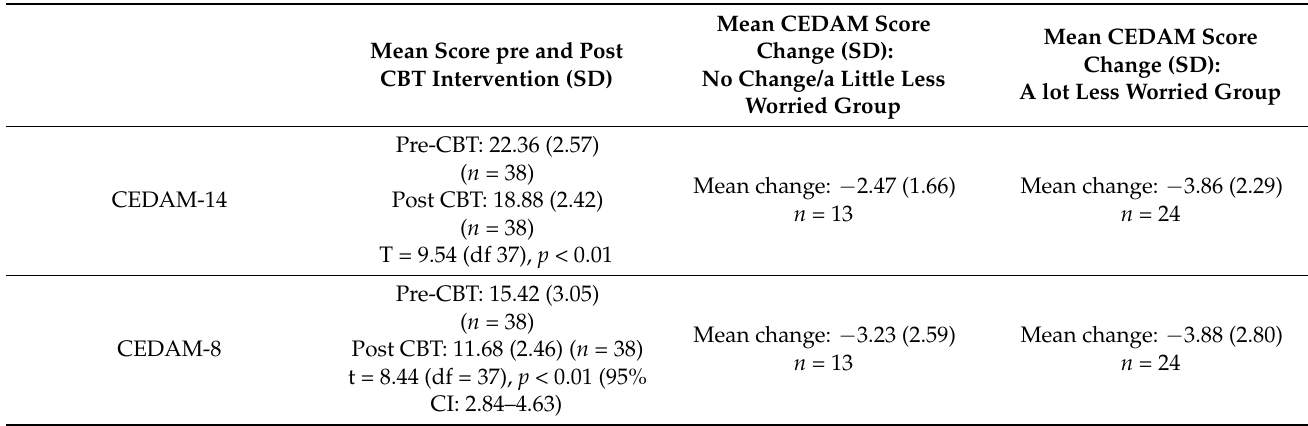
Table 3. Responsiveness of CEDAM